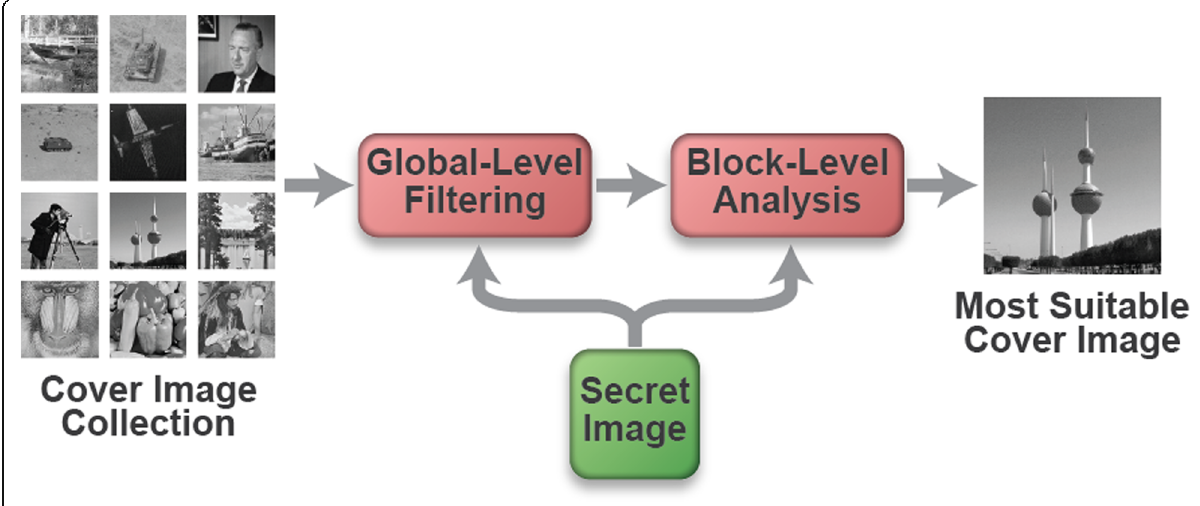
Fig. 1 High-level illustration of the proposed approach: most suitable cover image